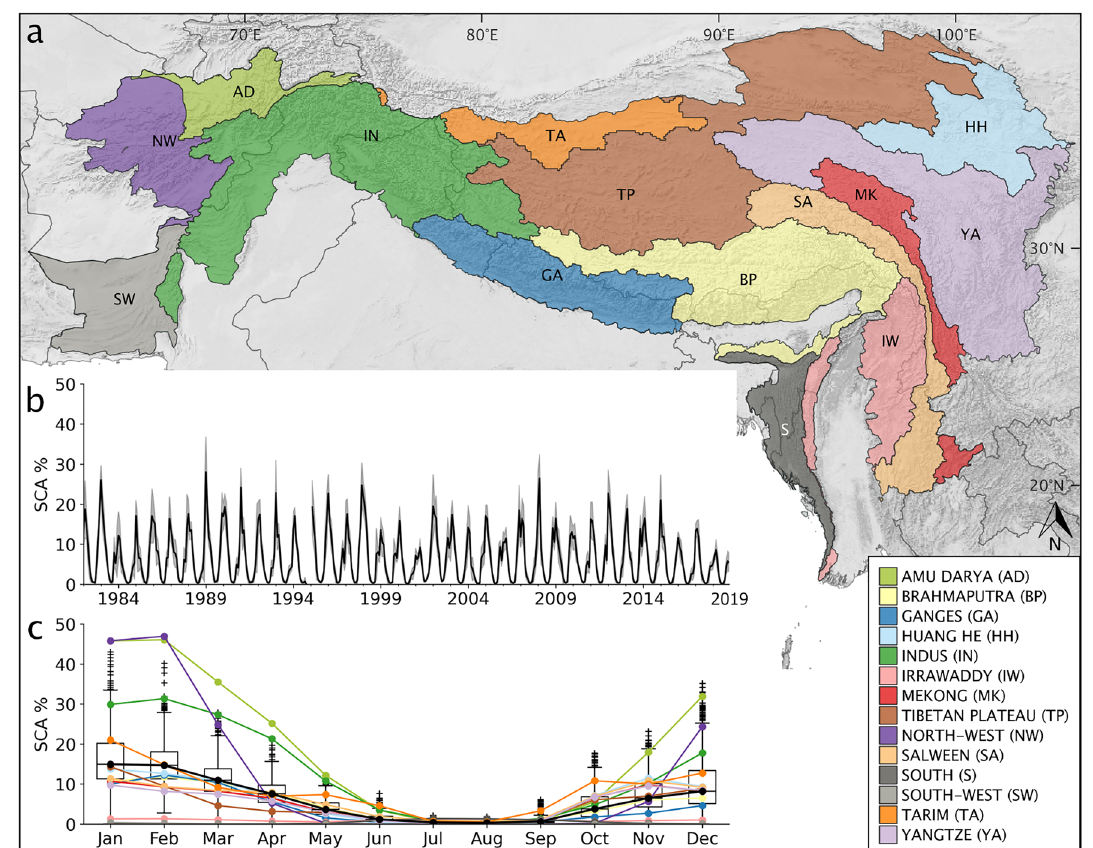
Figure 1. The Hindu Kush Himalaya region and its spatial seasonality of snow cover occurrence. ( a ) The map shows the entire HKH extent and the subdivision into 14 major river basins. Please not some individual basins are cut by the HKH outline applied. ( b ) Snow Cover Area Percentage time series, including monthly standard deviation (grey shaded area), for the HKH and the entire study period 1982–2018. ( c ) Monthly median of SCA % averaged over the entire study period for the whole HKH region (black) and all individual basins (coloured lines) over the course of the year. SCA values are given in numbers relative to the size of the respective region. Boxplots show median and IQR, whiskers the quartile to extreme ranges, and outliers are shown as crosses for the time series of the whole HKH region. All numeric details of c can be found in the Supplementary Table